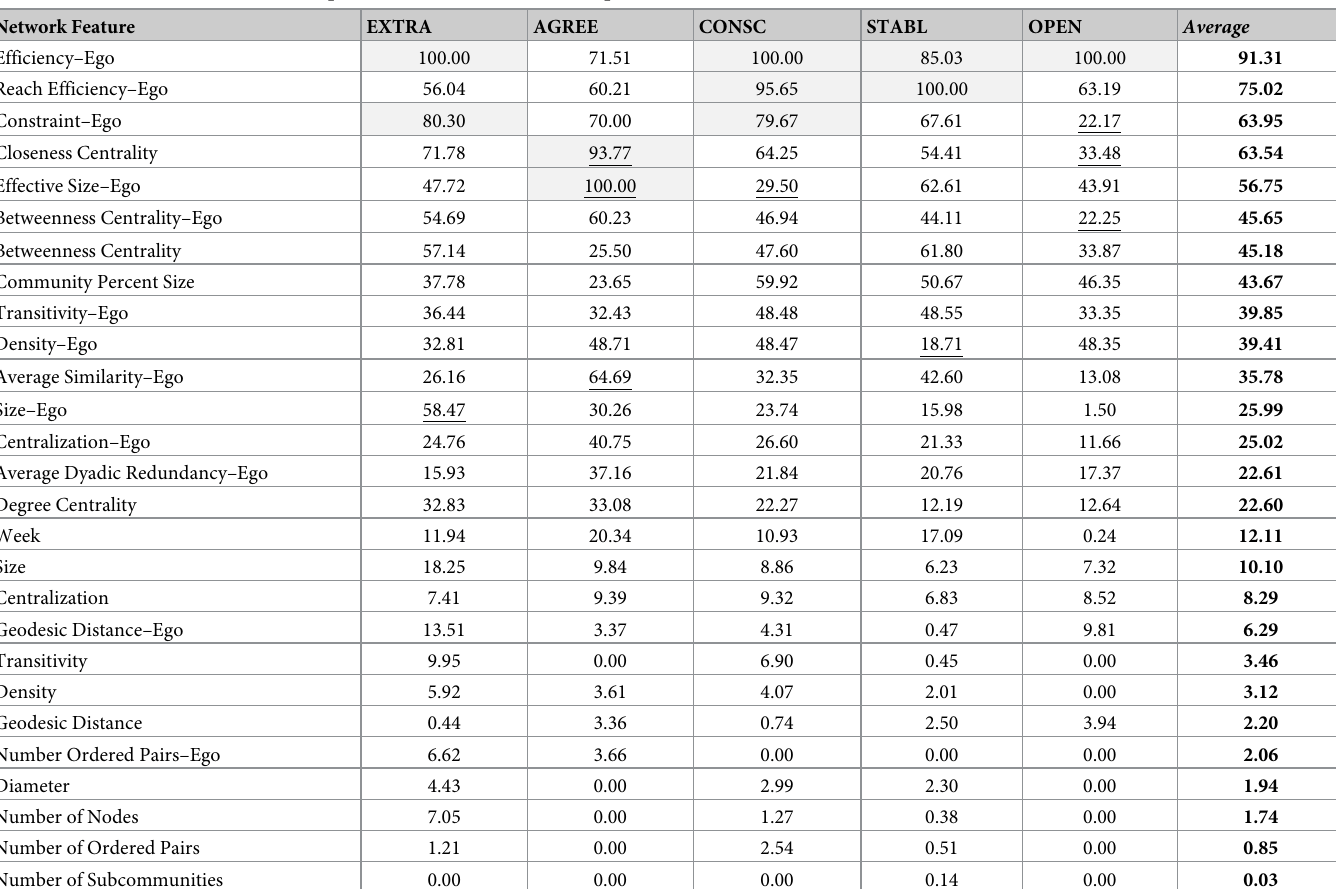
Table 4. Rank order of scaled feature importance scores across five factor predictive